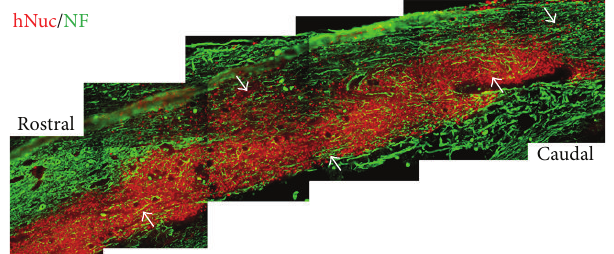
Figure 6: Direct transplantation of hNSPCs into the injured tho- racic spinal cord (T9) of adult Sprague-Dawley rats with contusive SCI showed robust long-term engraftment and extensive migration of donor-derived cells and induced host axonal growth along engrafted cells. At 12 weeks after transplantation, immunohisto- chemistry was conducted in the sectioned spinal cord tissues using anti-human nuclei marker (hNuc) and anti-NF and visualized with fluorescein or Texas red-labeled secondary antibodies. Many hNuc- positive cells (colored red) survived and migrated extensively to rostral and caudal parts of the injury site, including the spared tissue surrounding the lesion. Multiple neuronal processes expressing NF (colored green) extended over the engrafted human cells, as indicated by arrows. Scale bar: 200 𝜇